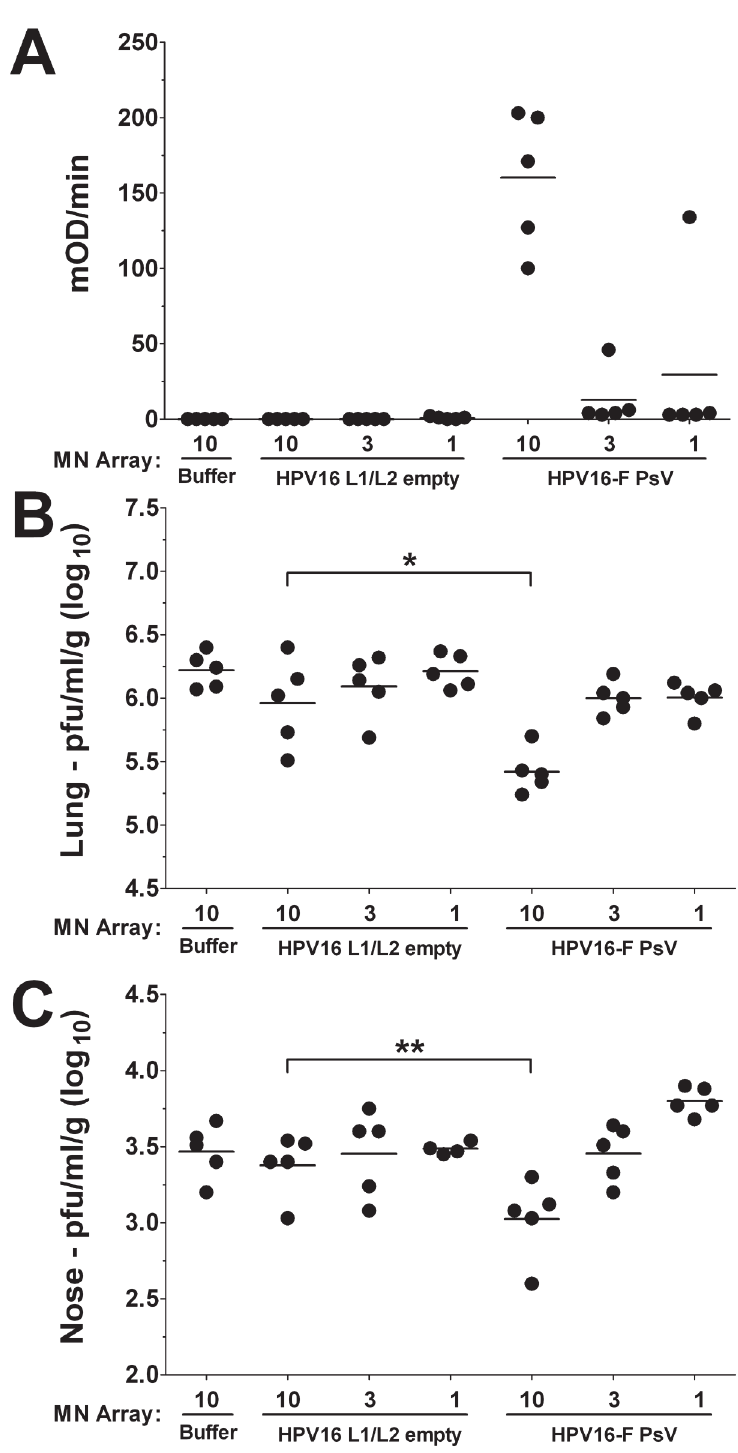
Fig 4. RSV protective antibody responses elicited by microneedle immunization with HPV16- F PsV. (A) Serum antibodies specific for RSV F protein were detected three weeks after the last immunization with microneedle arrays (MN Array; same animals depicted in Fig. 2). Mice were then challenged intranasally with 10 7 pfu of RSV A2. After 5 days RSV titers were measured in the (B) lung and (C) nose by RSV plaque assays. * p = 0.04, ** p =